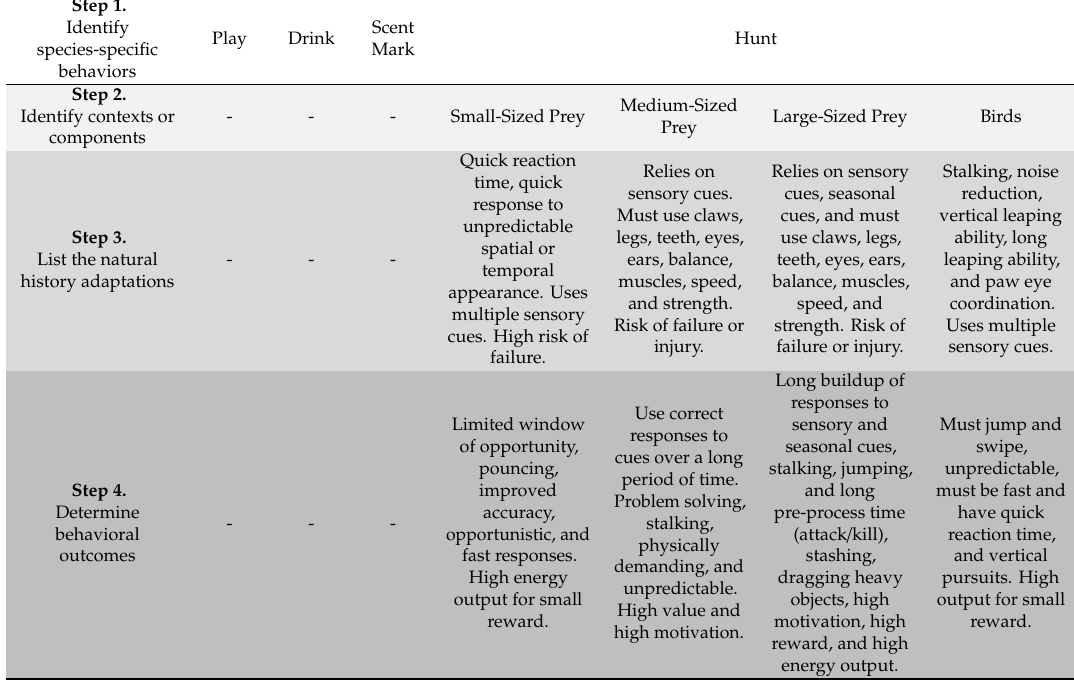
Table 3. Sample outcome-based behavior workflow for snow leopard hunting behavior